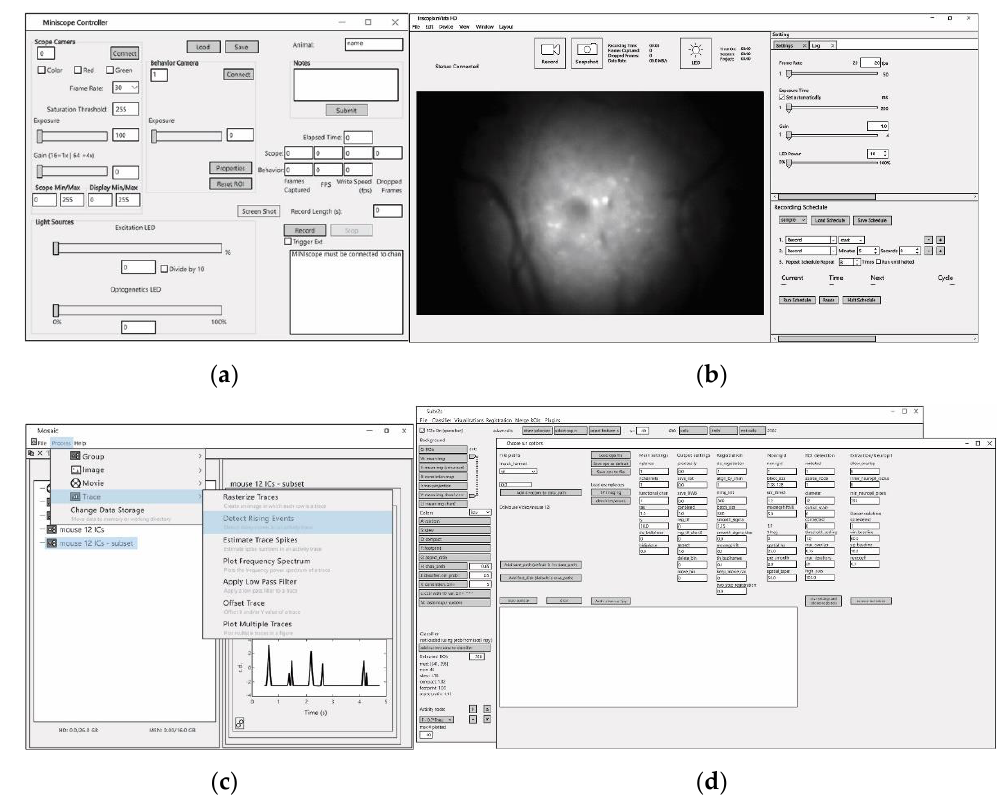
Figure 1. Optical brain-machine interface (O-BMI) systems. ( a ) Miniscope; ( b ) nVista; ( c ) Mosaic; ( d ) Suite2p. Table 2. Design analysis of existing optical brain-machine interface (O-BMI) systems.